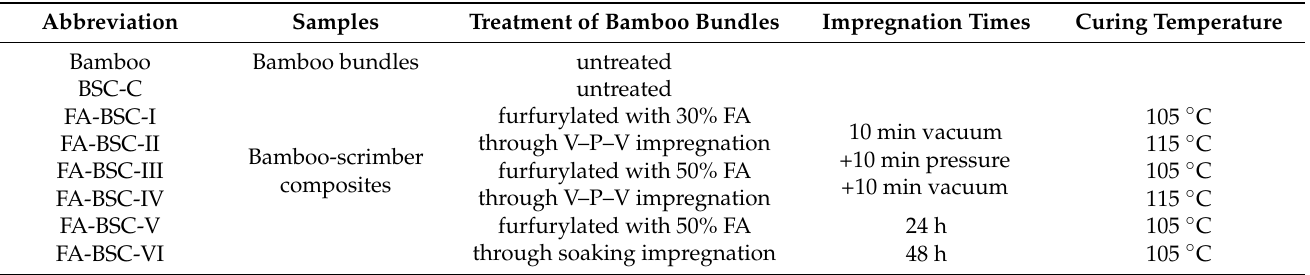
Table 1. Abbreviation and processing-technology information of